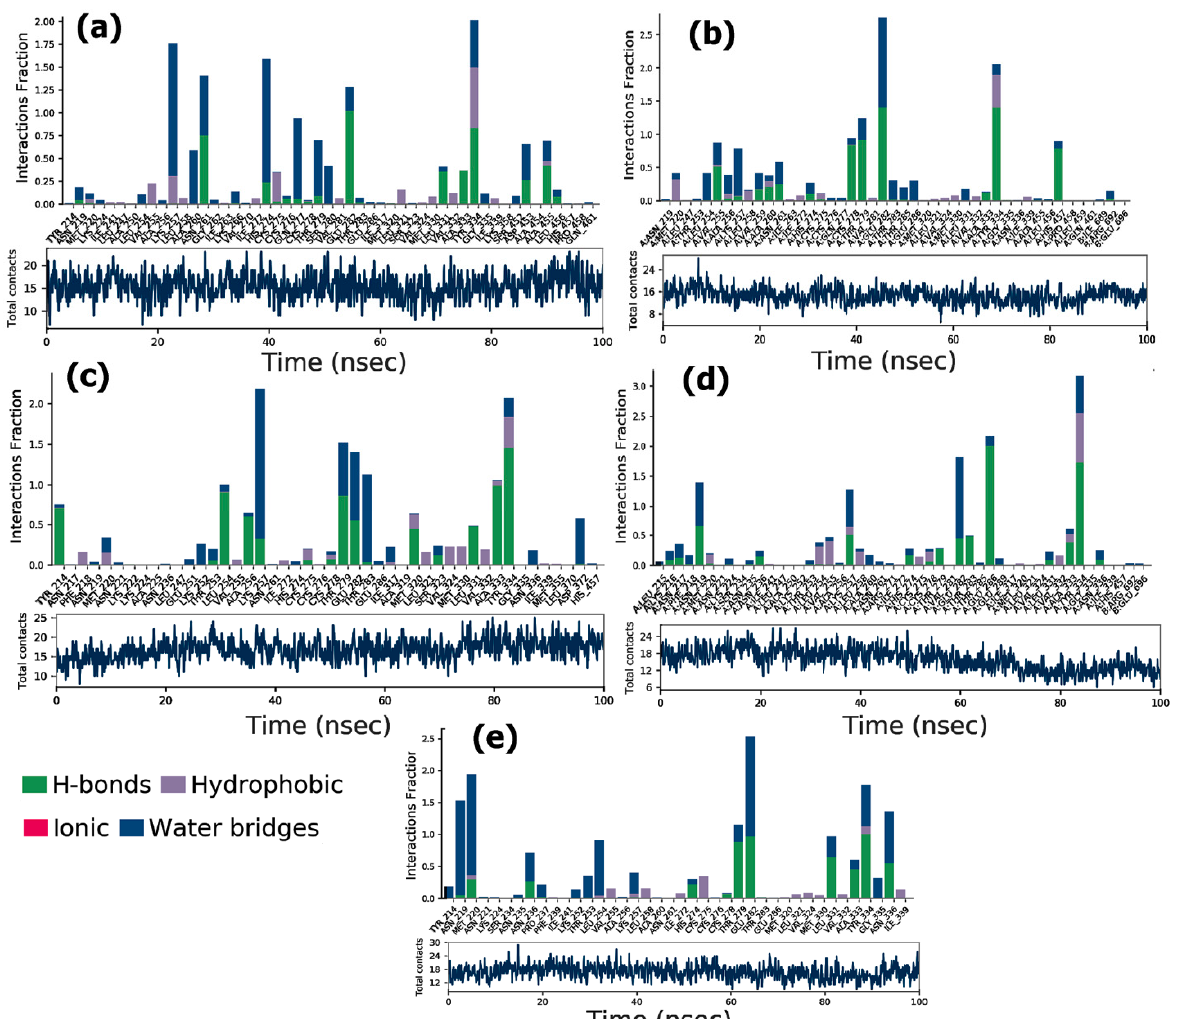
Figure 11. Protein ligand contacts of PPAR α -ligand complexes with ( a ) Pep (top); total number of contacts with Pep (bottom); ( b ) Mut1 (top); total number of contacts with Mut1 (bottom); ( c ) Mut2 (top); total number of contacts with Mut2 (bottom); ( d ) Mut3 (top); total number of contacts with Mut3 (bottom); ( e ) Mut4 (top); total number of contacts with Mut4 (bottom).